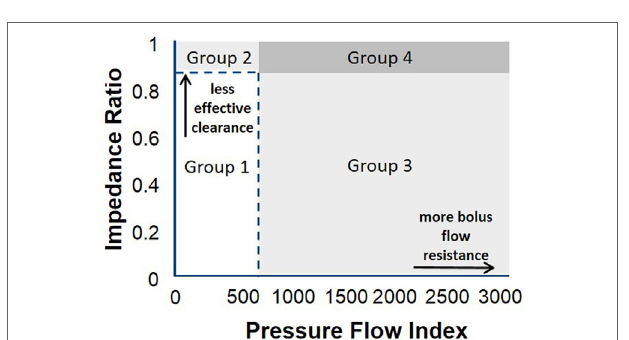
FigURe 3 | Pressure flow matrix: this matrix visually presents the combination of pressure flow index (PFI) with the impedance ratio (IR), aiming to dichotomously separate outpatients with dysphagia who have predominantly abnormal bolus clearance and/or those with abnormal bolus resistance at the esophago-gastric junction (EGJ) (16). The pressure flow matrix shows on the vertical axis the bolus data of patients with normal and abnormal flow resistance and on the horizontal axis the bolus data of patients with normal and abnormal bolus clearance. Depending on the combined value of these two metrics, the predominant pressure flow pattern becomes clear. The matrix consists of four quadrants and indicate the following groups: Group 1: patients with normal effective transit and normal flow resistance across the EGJ; Group 2: ineffective transit and normal bolus flow resistance across the EGJ; Group 3: effective transit but increased bolus flow resistance across the EGJ; Group 4: ineffective transit and increased bolus flow resistance across the EGJ. It is expected that control subjects will have a low PFI and a low IR, and these are indicated by the dotted line. Patients with esophageal atresia are hypothesized to present in Groups 2 and 4, but further research is needed to consolidate this hypothesis